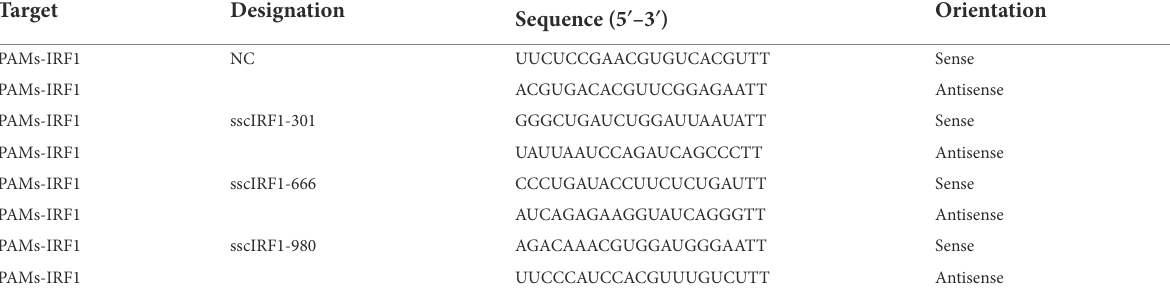
TABLE 4 Three pairs of siRNAs designed to silence the endogenous